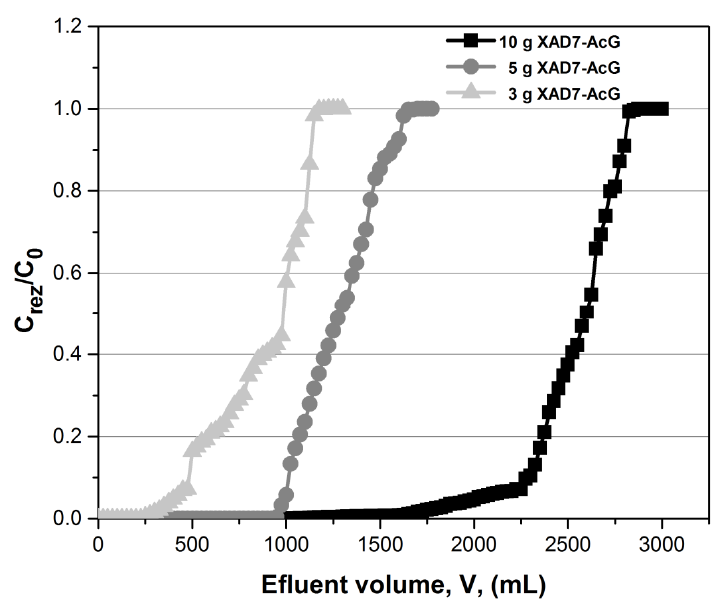
Figure 3. Breakthrough curves on Au (III) removal in the fixed-bed column, at various amounts of adsorbent material.